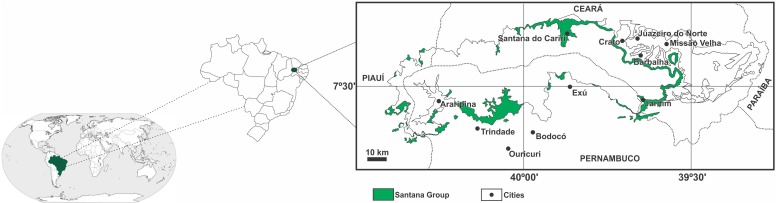
Location of the Araripe Basin.In featured (green) the Santana Group. Modified from Assine (2007).